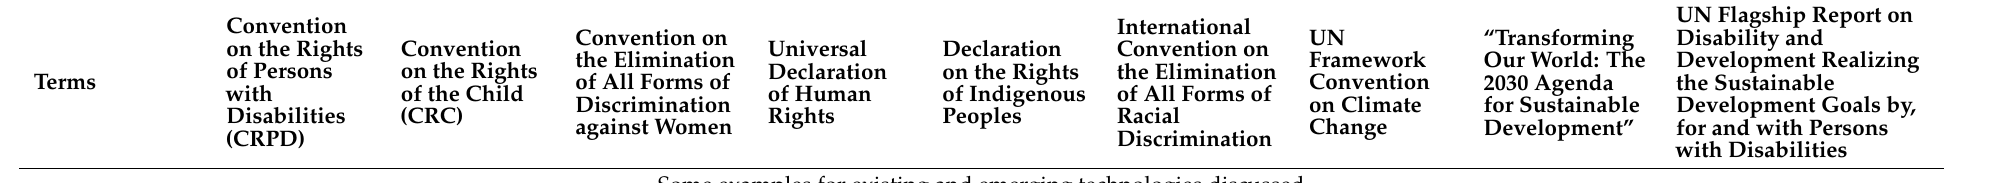
Table 19. hit counts for some established and emerging technologies we selected that are discussed as having an impact on the ‘social’ in the actual document such as the